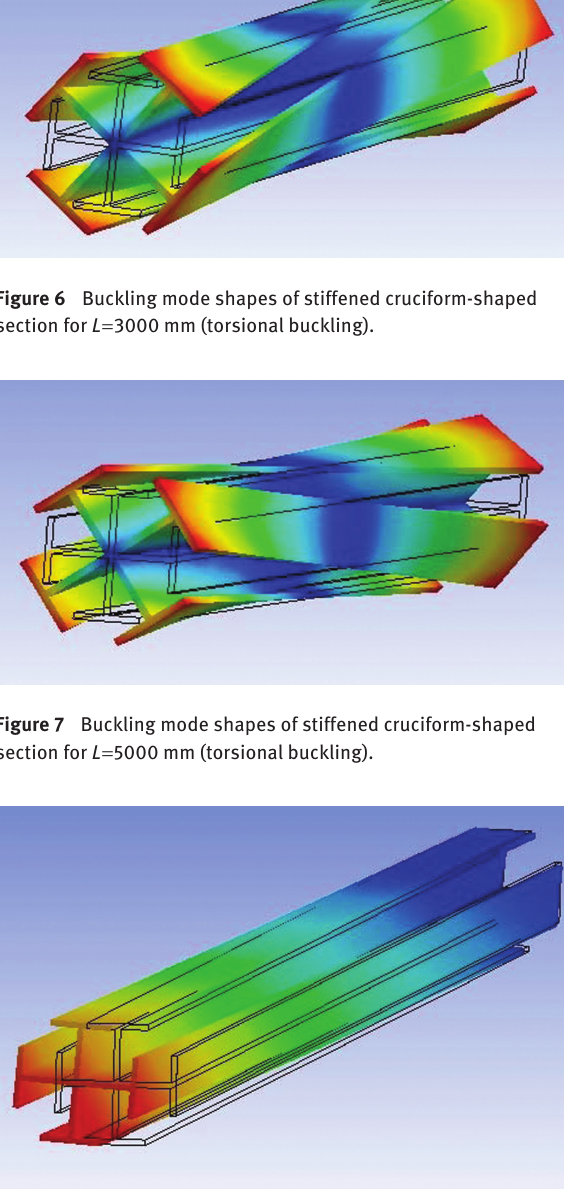
Figure 8 Buckling mode shapes of stiffened cruciform-shaped section for L = 10,000 mm (flexural